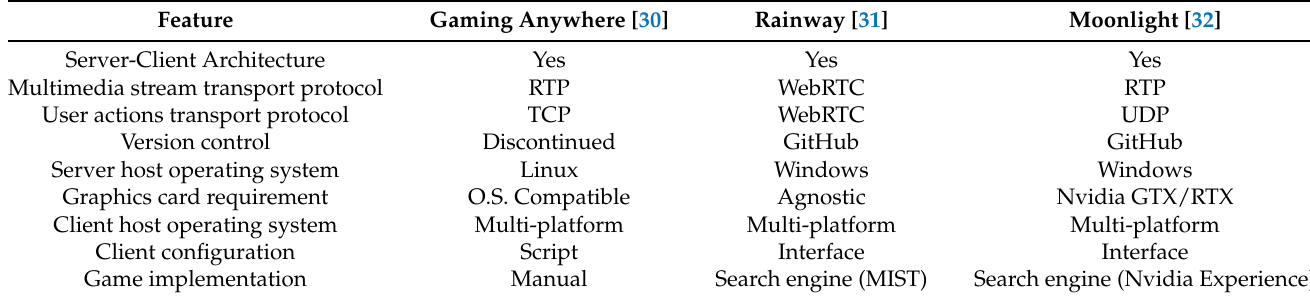
Table 1. Cloud Gaming open-source platform